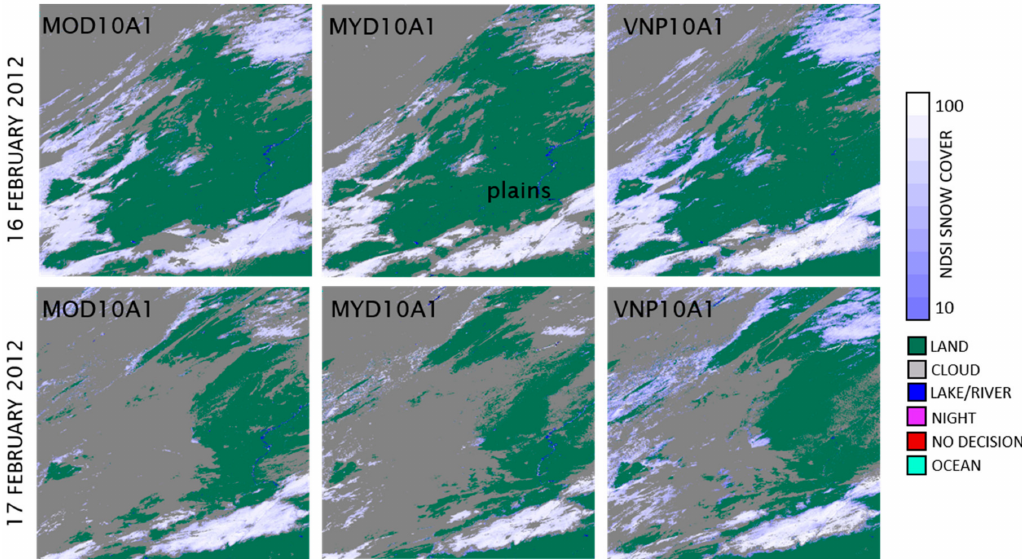
Figure 5. Snow cover products of Terra and Aqua from Collection 6 and S-NPP from Collection 1. The NDSI_Snow_Cover data layer for tile h10v04 MOD10A1 and MYD10A1 at 500 m resolution, and VNP10A1 at 375 m resolution, on 16 February 2012 and on 17 February 2012, are displayed in array format. Images are not